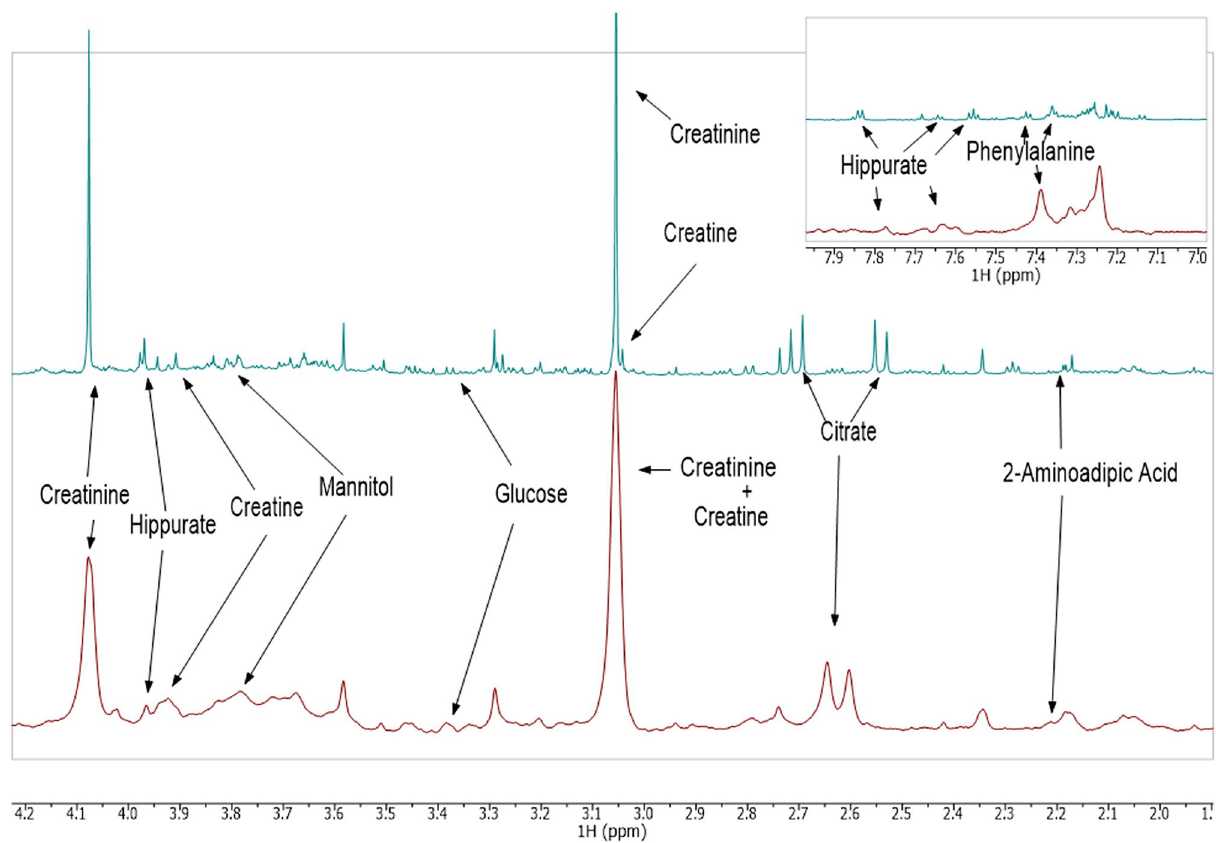
Figure 5. Comparison of the metabolomic fingerprints of tuberculosis (TB) identified in urine spectra analyzed by high-field Nuclear Magnetic Resonance (green) and low-field Nuclear Magnetic Resonance (red) showing the identification of the TB metabolite biomarkers. PC: Principal